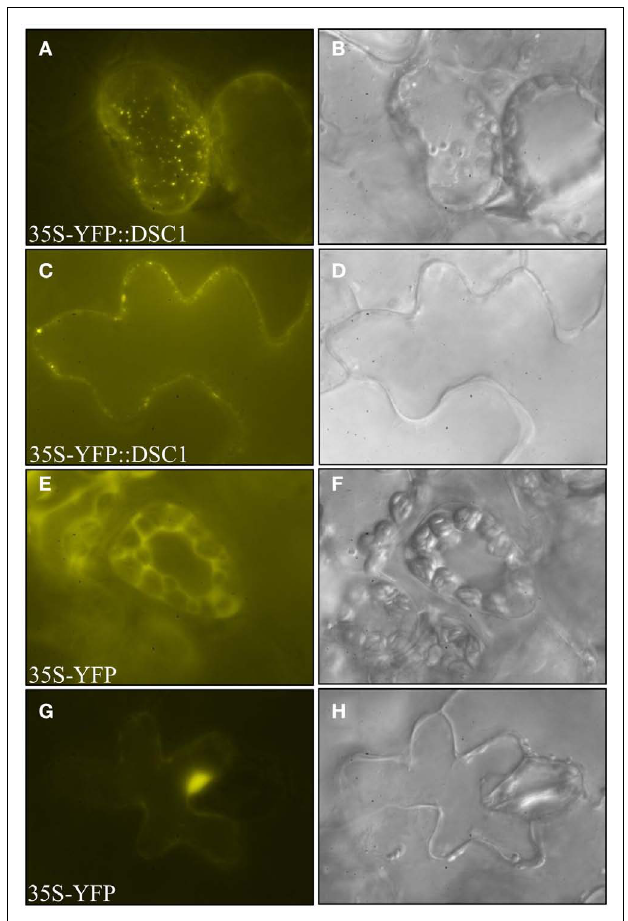
FIGUREA1 | Subcellular localization ofYFP-tagged DSC1 and 35S-YFP control construct. DSC1 localizes to punctate structures in ( A ) mesophyll and (C ) epidermal cells.The control construct has nucleo-cytoplasmic localization in ( E ) mesophyll and ( G ) epidermal cells. ( B,D,F,H ) Bright field images were taken of the cells located directly to the left. Images were obtained using epifluorescence